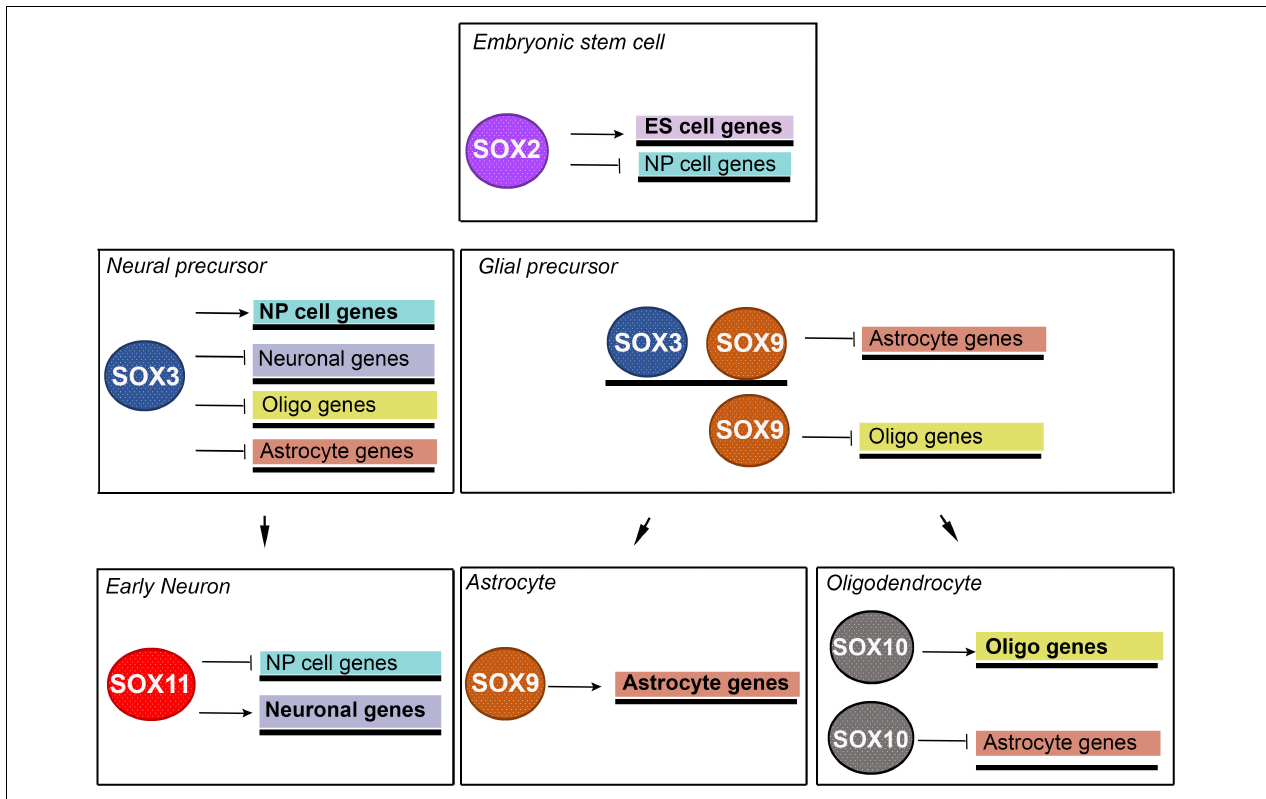
FIGURE 2 | Schematic illustration of proposed model for neuronal and glial lineage specification governed by sequentially acting SOX TFs. Neural precursor cell specific genes are repressed in ESCs by SOX2 and activated in neural precursor cells by SOX3. Neuronal specific genes are repressed in neural precursor cells by SOX3 and activated in early neurons by SOX11. Astrocyte specific genes are repressed in neural precursor cells by SOX3, in glial precursors by SOX3 and SOX9 and in oligodendrocyte by SOX10. These genes are activated in astrocytes by SOX9. Oligodendrocyte specific genes are repressed in neural precursor cells by SOX3, in glial precursor cells by SOX9 and activated in oligodendrocytes by SOX10. NP- neural precursors; Oligo – oligodendrocyte. [Modified from Bergsland et al. (2011) and Klum et al.